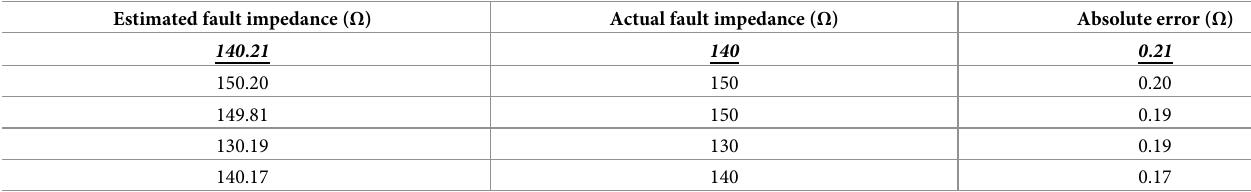
Table 12. Fault impedance estimation